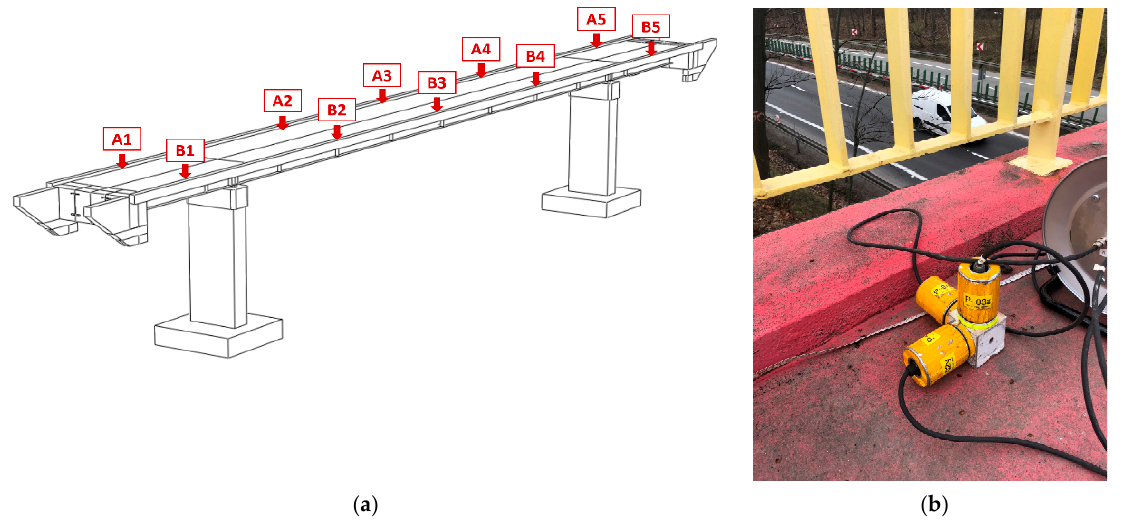
Figure 5. ( a ) Layout of the measurement points located along the footbridge (point A1–A5, B1–B5); ( b ) The A1 measurement point equipped with three piezoelectric high sensitivity (10,000 mV/g) ac- celerometers.